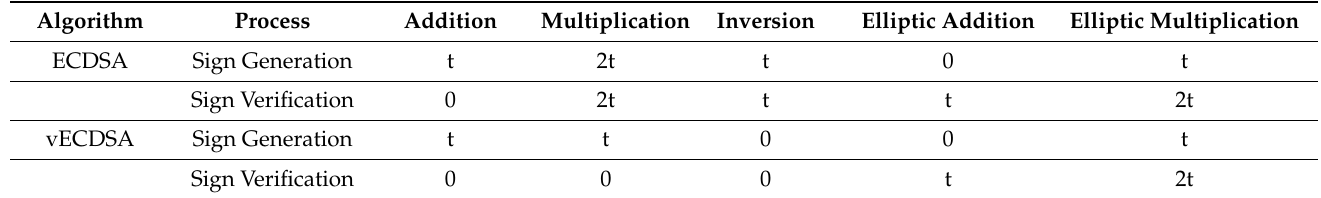
Table 2. Emerging important application domains of blockchain-based